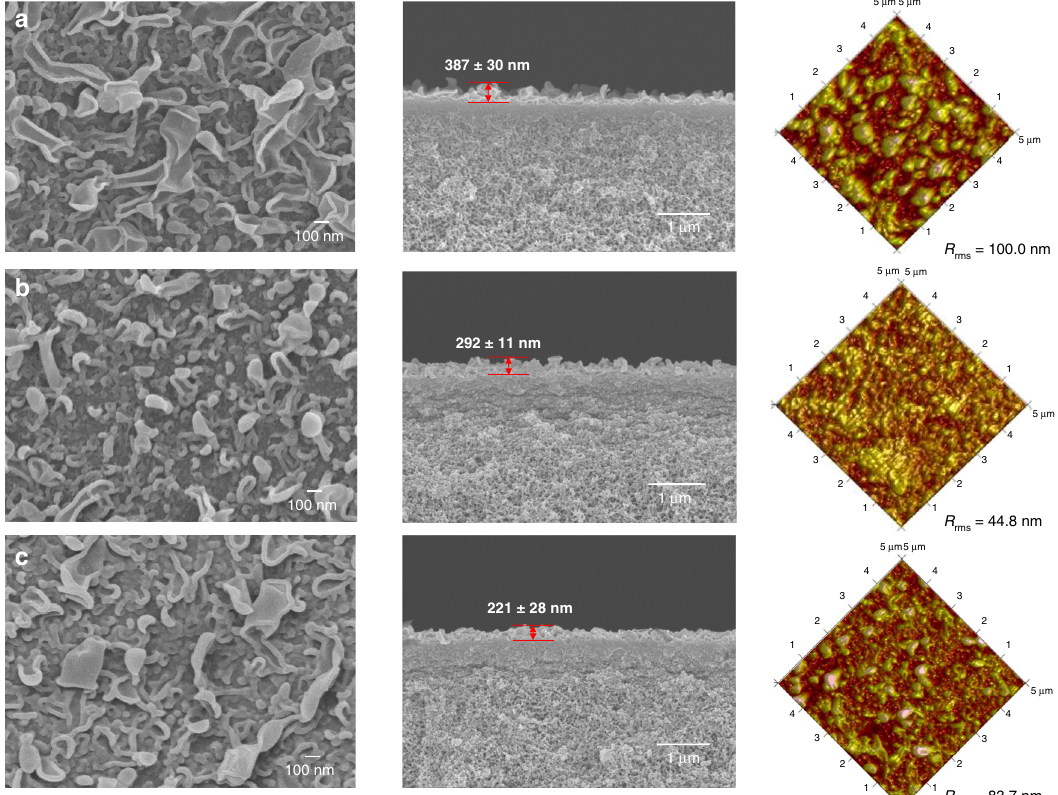
Fig. 2 Surface morphologies. FESEM and AFM images of the polyamide layers for a TFC-0, b TFN-STCAss-1.5, and c TFN-SCA-1.5.